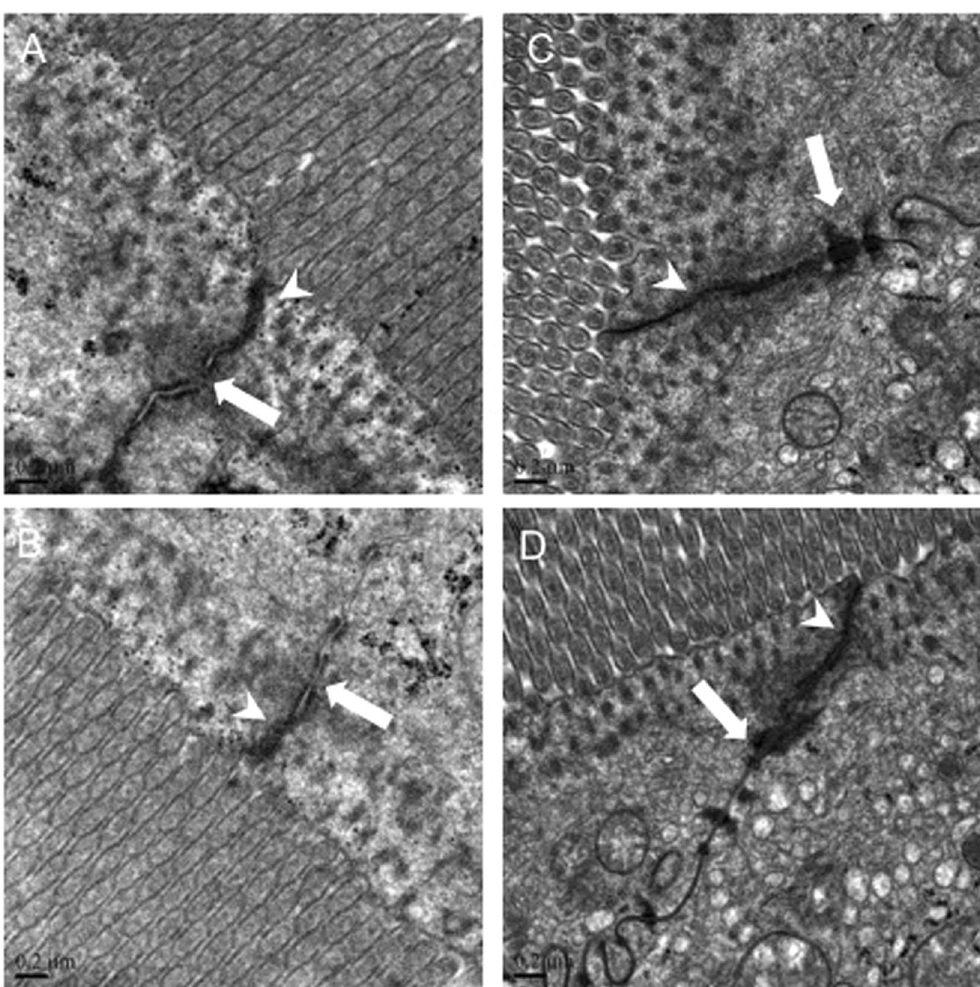
Figure 4. The effects of a P2X7R blockade on TJ morphology. Representative images of TJ morphology in the BzATP-treated ( A ), control ( B ), A740003-treated ( C ), and sham ( D ) groups assessed at 48 hours after CLP. Arrowheads indicate tight junctions and white arrows indicate